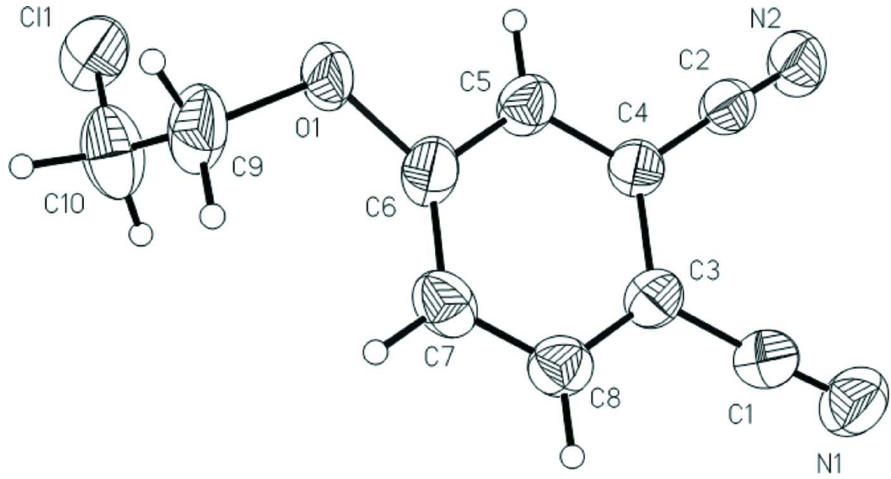
Figure 1 The structure of the title compound, (I), showing 35% probability ellipsoids and the atom numbering scheme. For clarity only atoms of the major disorder component are